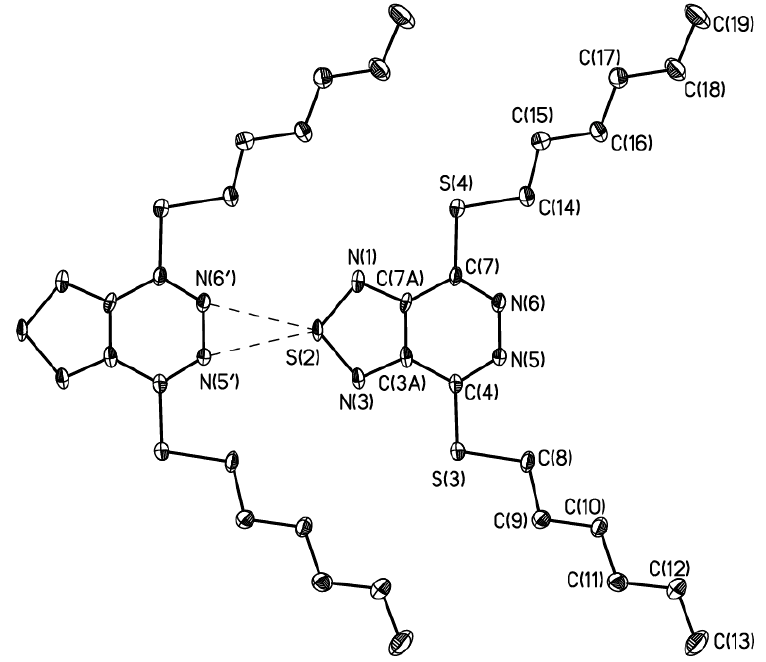
Figure 2. Fragment of the S . . . η 2 -(N=N) bound chains in a crystal of 10b in representation of atoms by thermal ellipsoids (p = 50%).